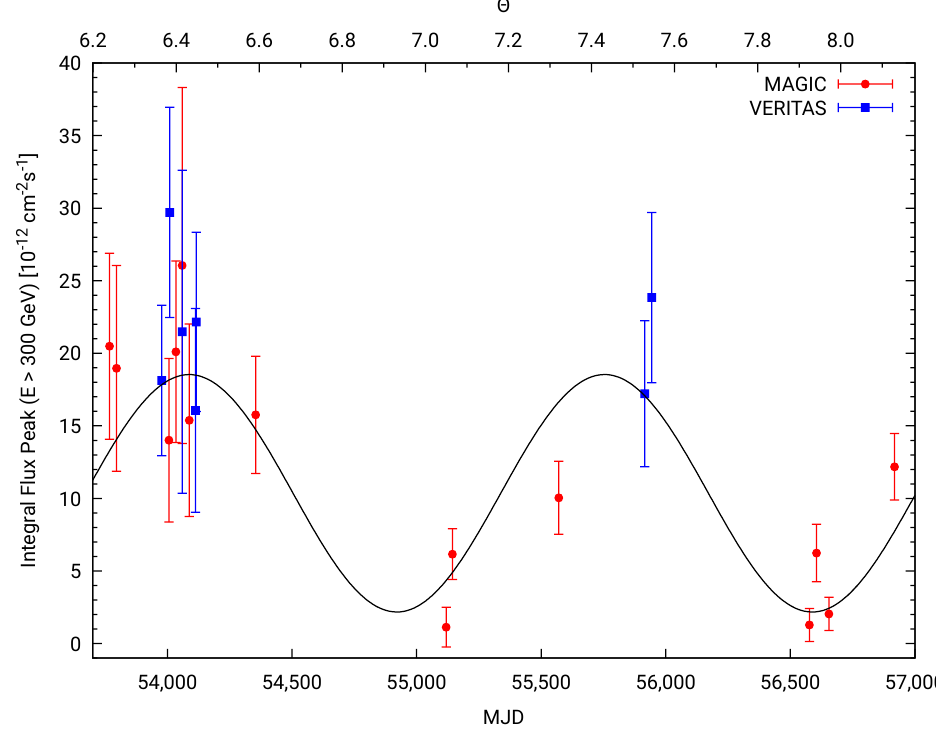
Figure 1. VHE γ -ray data resulting from MAGIC (reda points) and VERITAS (blue squares) obser- vations. The data for this plot were taken from Ahnen et al. [14] and correspond to the peak fluxes of each orbital cycle (for details see their Section 3.2), plotted against time (MJD, lower axis) and long − term phase Θ (upper axis). The solid black curve is the result of fitting these data with a sine function, as described here in Section